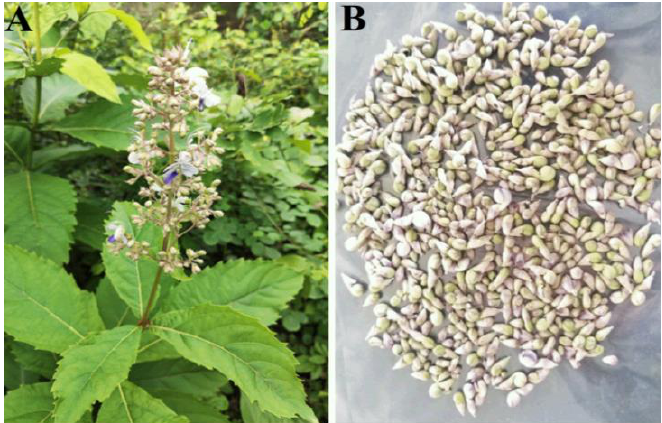
Figure 1. ( A ) Plant habit of R. serrata with flowering twig, and ( B ) Flower